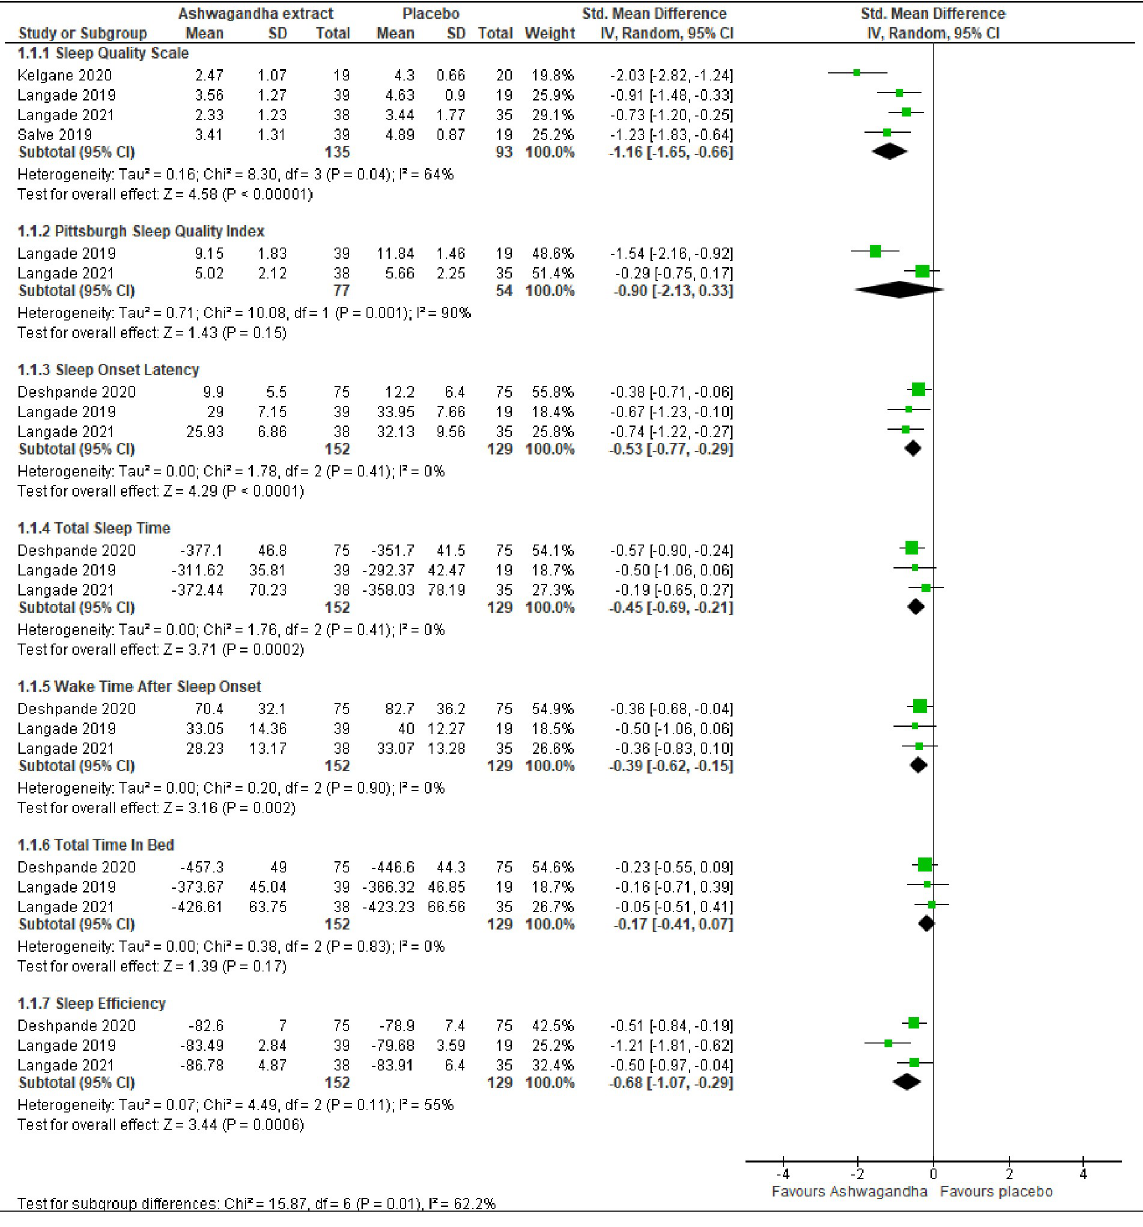
Fig 3. Forest plots of Ashwagandha versus placebo on sleep by type of